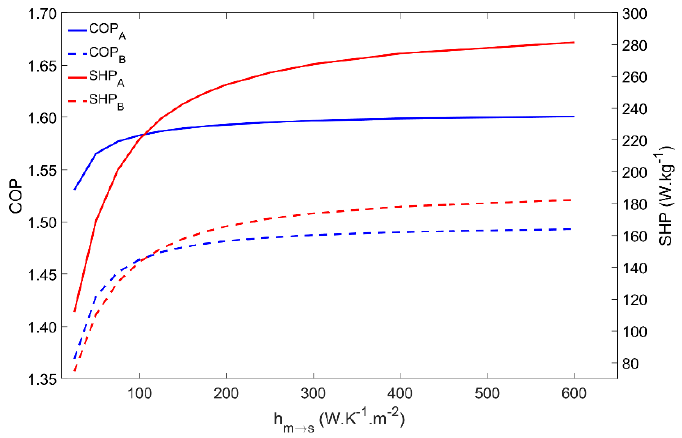
Figure 7. COP and SHP as function of the metal–adsorbent heat transfer coefficient for scenarios A and B.